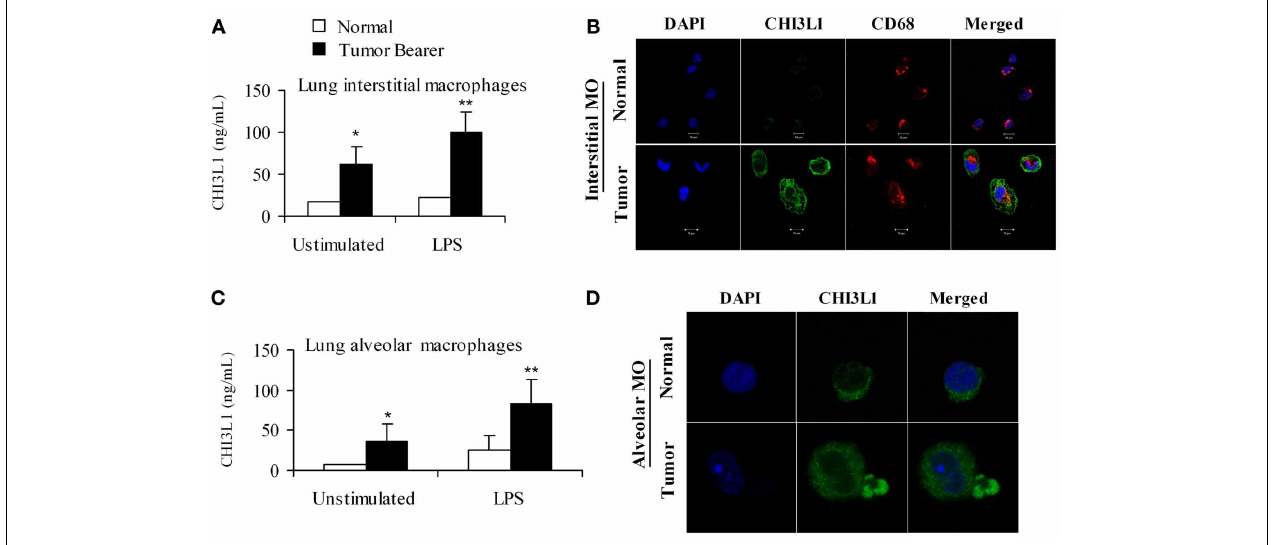
FIGURE 5 | CHI3L1 is expressed at higher levels in pulmonary macrophages from 2-week mammary tumor bearing mice. (A) CHI3L1 ELISA of interstitial macrophages from normal and mammary tumor bearers; (B) Cellular co-localization of CHI3L1 with CD68, a macrophage marker was visualized by confocal